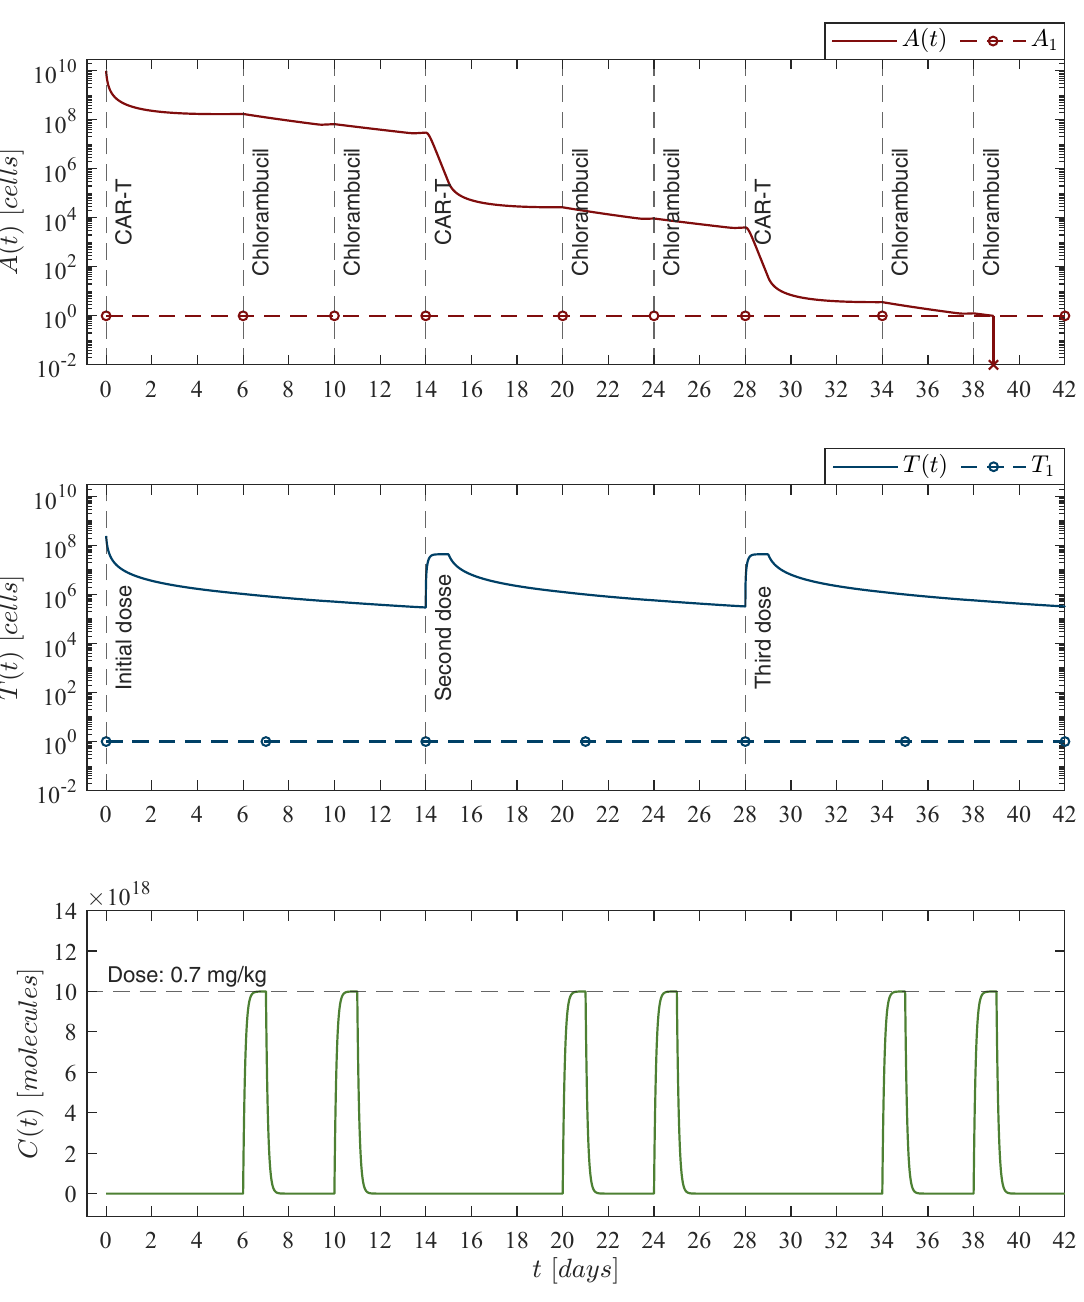
Figure 7. Constant chemoimmunotherapy case. In this scenario we incorporated consecutive ad- ministrations of the chlorambucil chemotherapy drug with a constant dose. Numerical simulations allowed us to determine both the amount dose and the day at which the treatment should be applied to achieve leukemia cells eradication. The chemoimmunotherapy protocol was established as follows for a hypothetical 80 kg leukemia patient: three immunotherapy infusions of 245,633,284 CAR-T cells at days 0, 14, and 28 as illustrated in the middle panel; six administrations of the chlorambucil chemotherapy drug with a dose of 56 mg ( 0.7 mg/kg ) at days 6, 10, 20, 24, 34, and 38. The combined therapy is illustrated in the upper panel with the leukemia cells evolution [ A ( t )] which go below the threshold of complete eradication by day 39 [ t = 38.87 ] for an initial non-solid tumor population of 10 10 cancer cells. Total doses of the chemoimmunotherapy treatment are as follows: 336 mg of chlorambucil, and 736,899,852 CAR-T cells. For this case, parameter values are set as follows: ρ A = 0.1680, ρ T = 2.9409 × 10 − 13 , µ T = 1/14, α T = 1.2560 × 10 − 7 by Equation (12), µ AC = 0.3712, and µ TC =